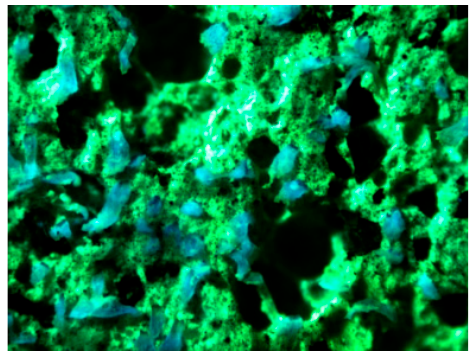
Figure 8. Fiber dispersion